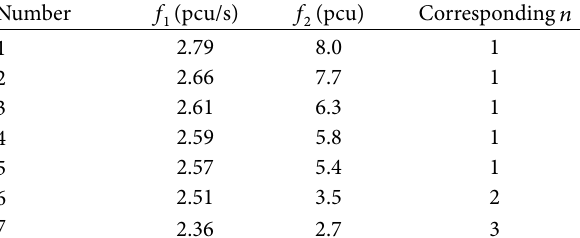
Table 4: Pareto frontier of the evening peak